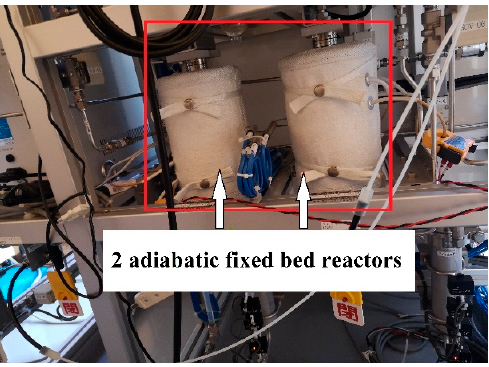
Figure 3. View of the two adiabatic fixed-bed reactors used for the methanation